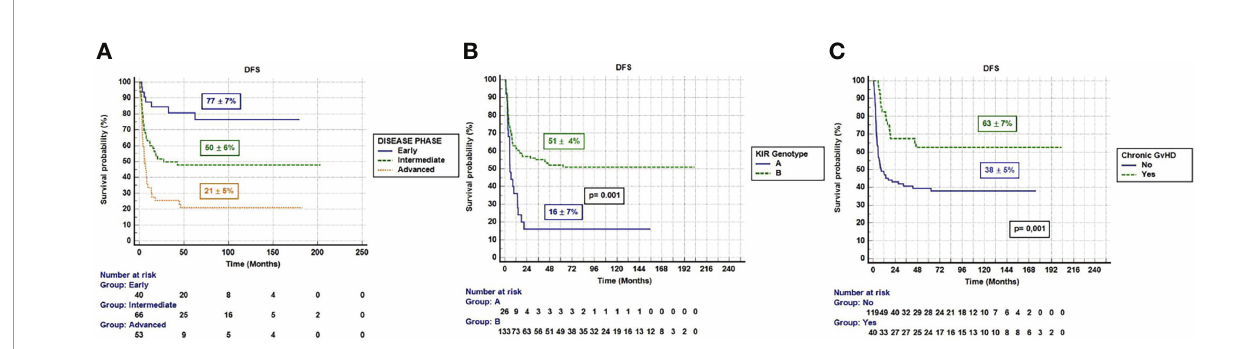
FIGURE 1 | (A) DFS according disease phase (Early: 1st CR, Intermediate: 2nd CR, Advanced: >2nd CR or active disease). (B) DFS according donor KIR Genotype. (C) DFS according chronic